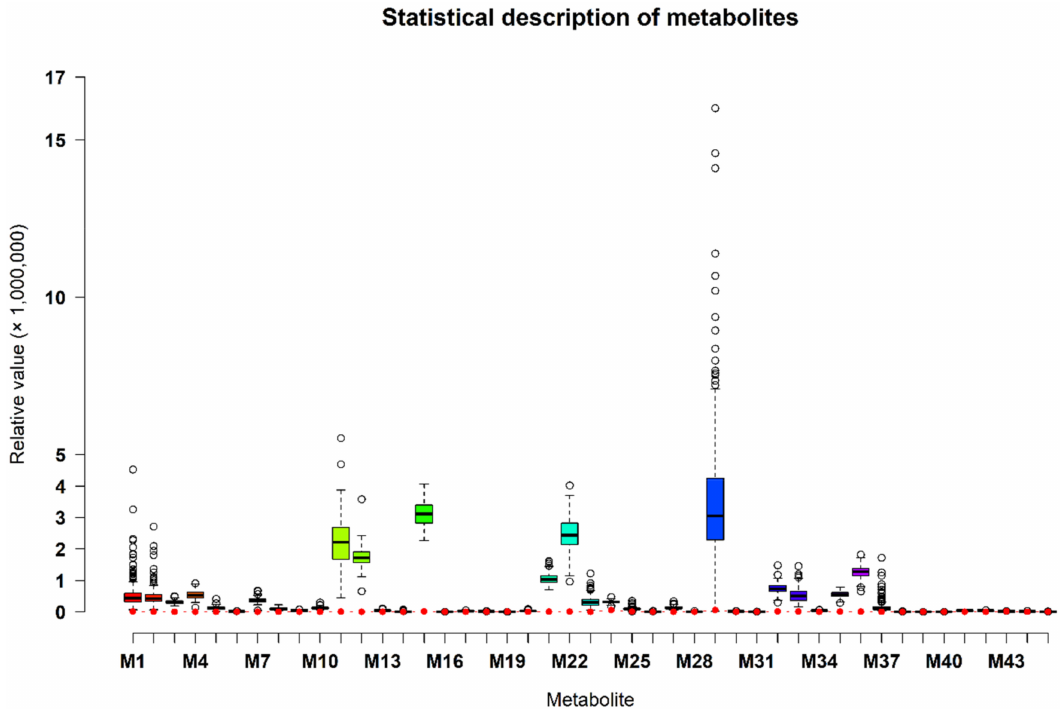
Figure 7. Statistical description of 45 metabolites from combined two sampling times. Note: The red solid circle indicates the limit of detection (LOD) relative value of each metabolite. LOD refers to the lowest value of a metabolite that the LC-MS method can detect. M1 to M45 indicate the metabolites of